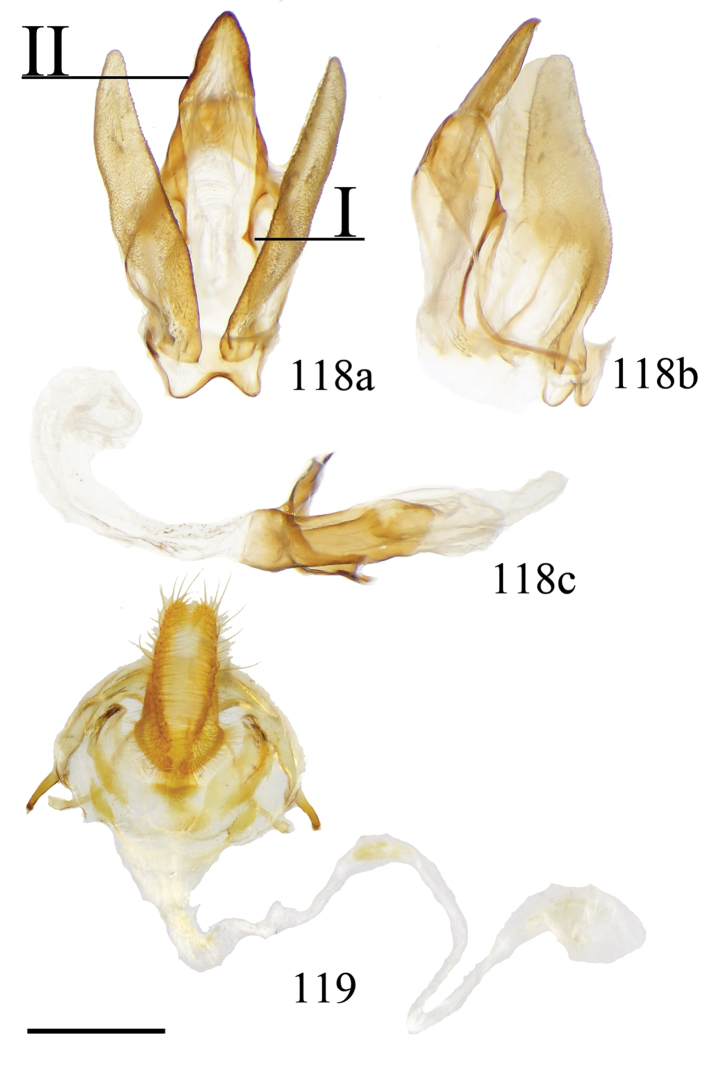
Genitalia of Citrallaruminaa ventral b lateral c phallus. Roman numerals refer to characters discussed in the text. 118 Male, Costa Rica, Heredia, Chilamate, Finca Selva Verde, St Laurent diss.: 9-20-17:4 (MGCL) 119 Female [ventral], holotype, Panama, Volcan de Chiriquí, 2000-3000 ft, genitalia vial NHMUK 010402303 (NHMUK). Scale bar: 1 cm.